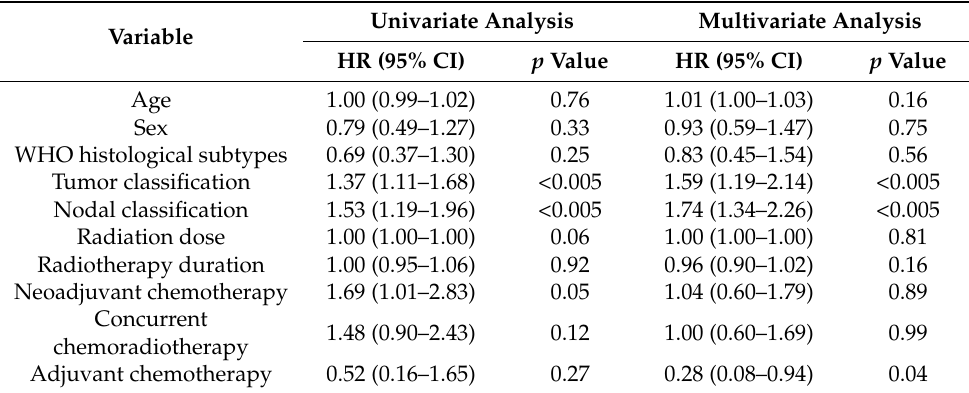
Table 2. Cox proportional hazards regression for progression-free survival.